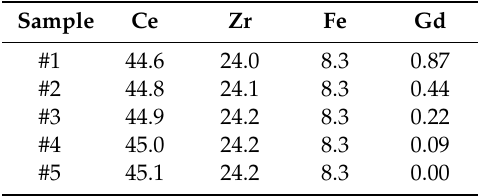
Table 1. Elemental composition (wt%) of the surrogate nuclear fuel debris.